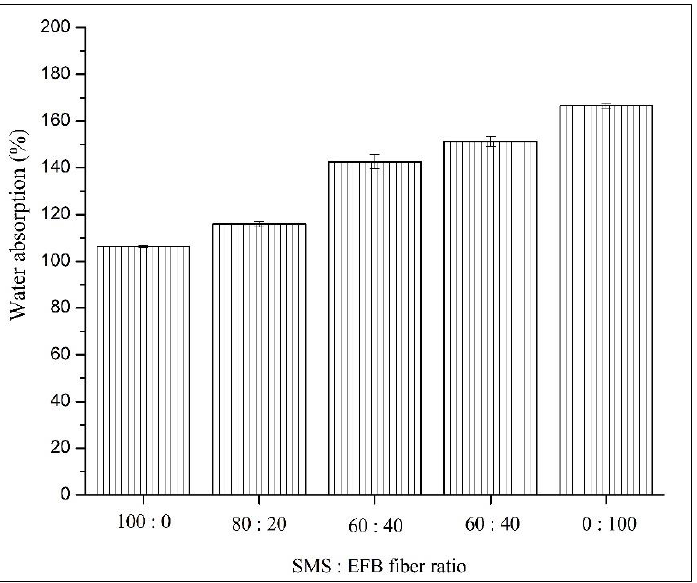
Figure 12. Effect of the fiber ratio of SMS and EFB fiber on the water absorption of the sandwich composite panel.